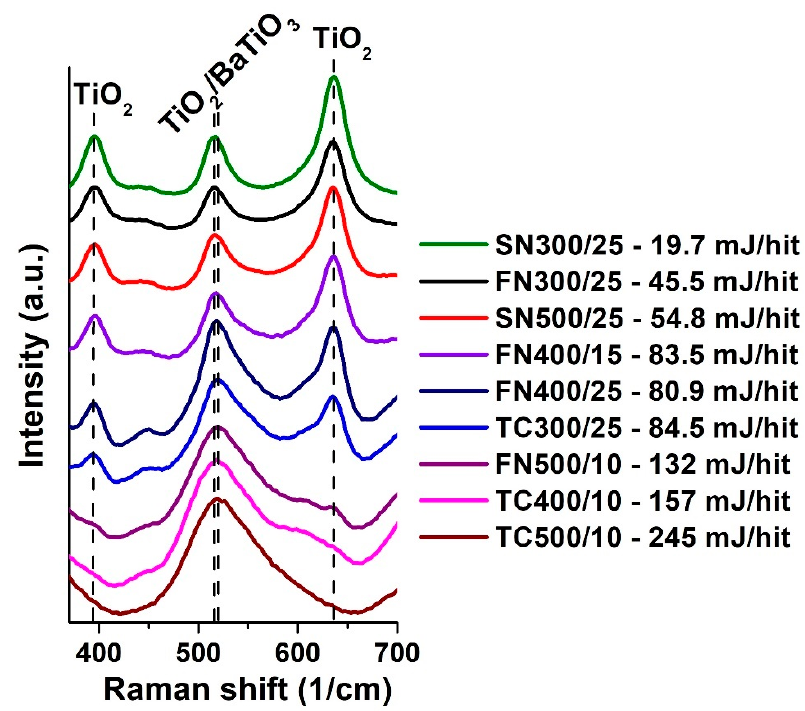
Figure 1. Raman spectra of all samples treated at different ball-impact energy (E b ).